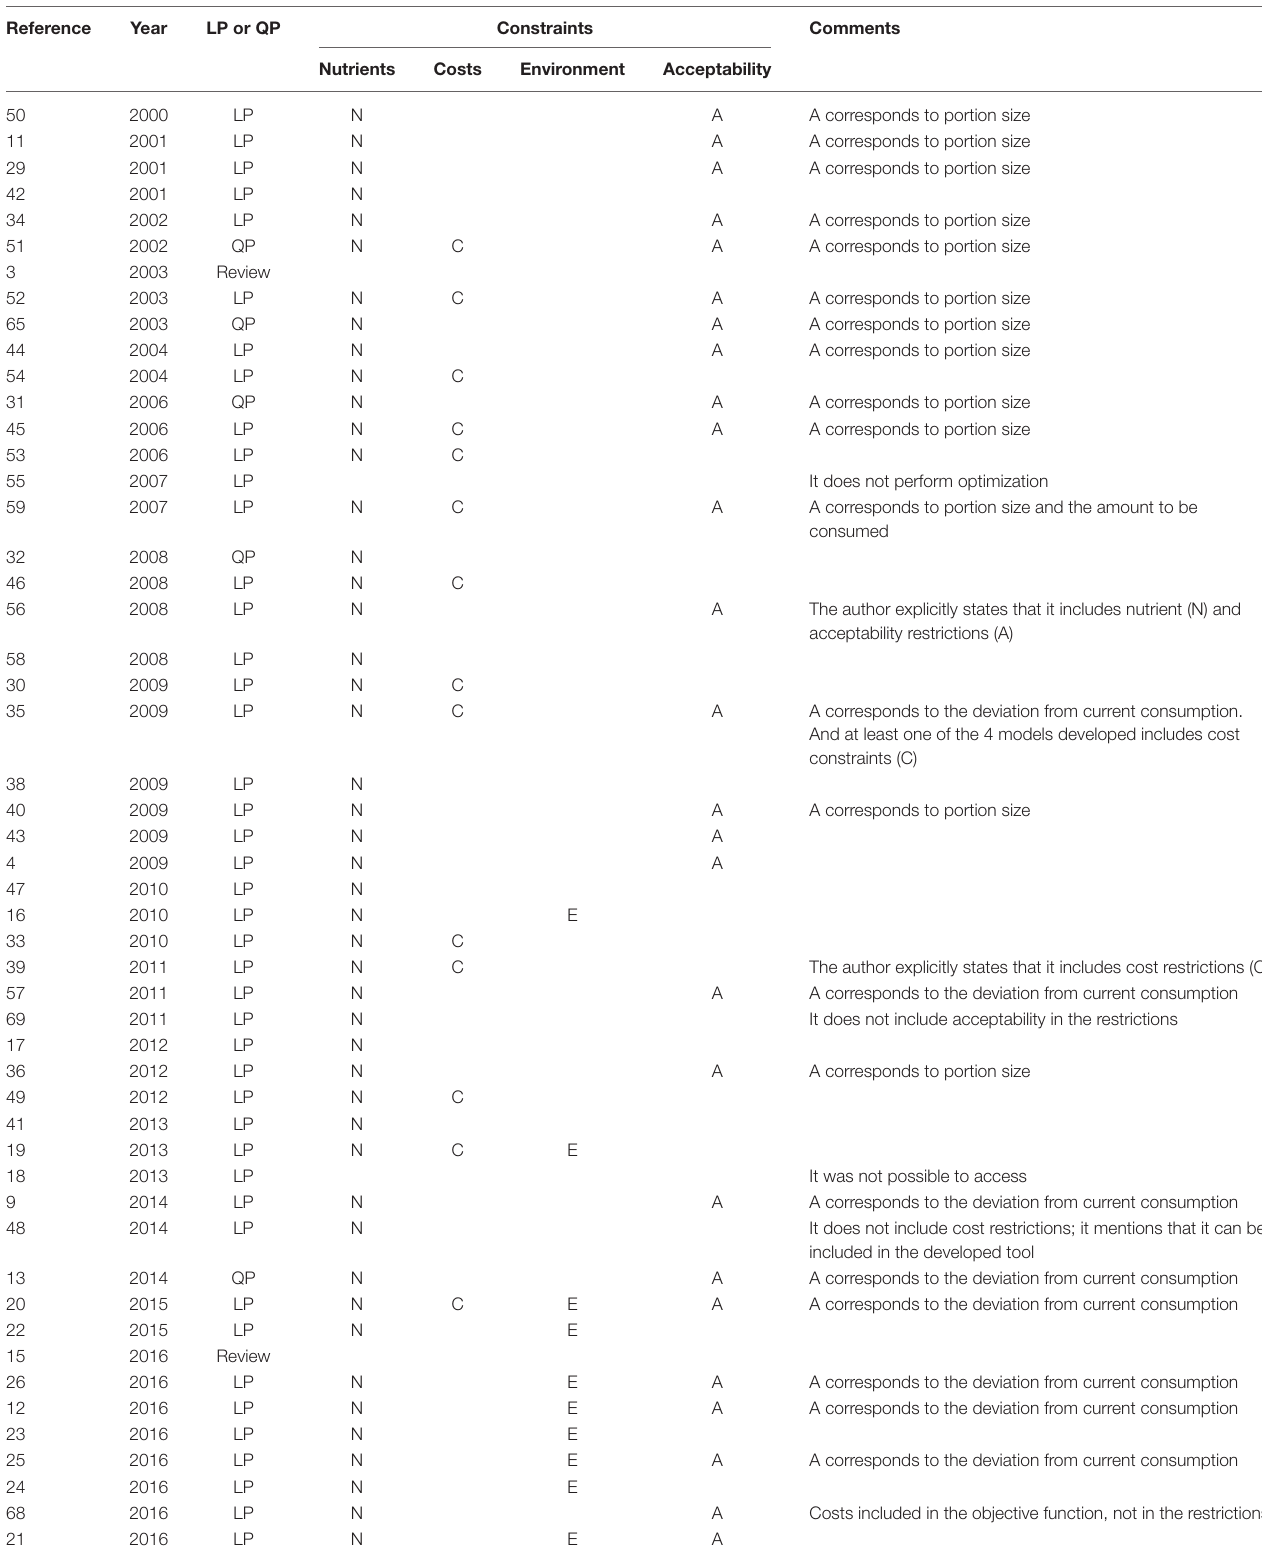
TABLE A1 | Short overview of the reviewed papers, year published, type of programming (linear or quadratic) and constraints used.